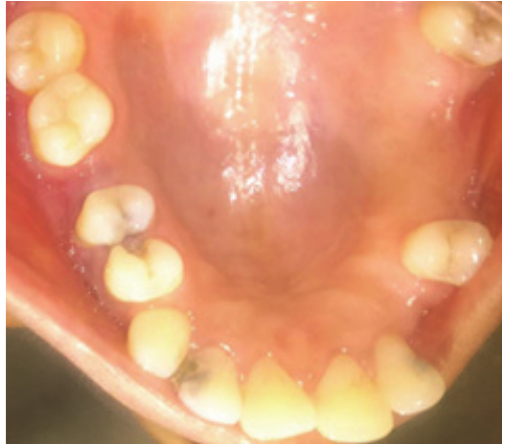
Figure 2: Intraoral image of #14 and #15 region shows no oblitera- tion of buccal vestibule.